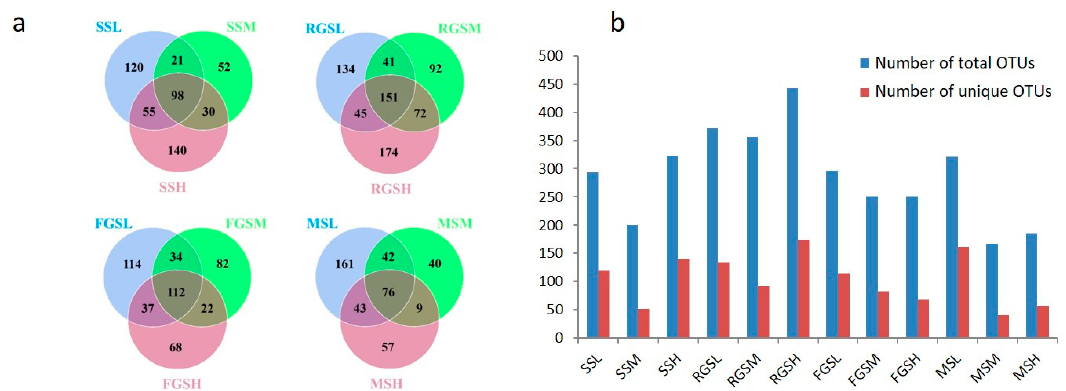
Figure 4. Comparison of fungal communities at different altitudes. ( a ) Venn diagram for samples among different combinations. Each circle represents a sample (group), with the number in the overlapping circles representing the numbers of OTUs shared between those samples (groups), and the number in the non-overlapping regions representing the number of unique OTUs of that sample (group). ( b ) Statistics of the OTUs numbers at different growth stages. Total OTUs refers to all the OTUs in a certain growth stage. Unique OTUs are those specific to a particular growth